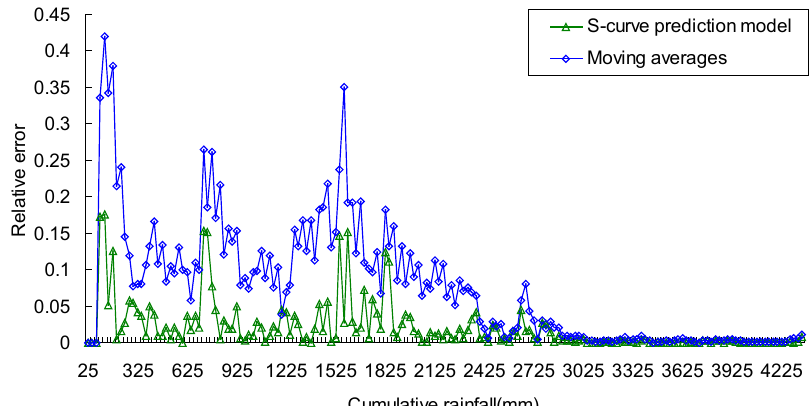
Figure 16. Relative error analyses of S-curve prediction model and moving averages model (Sample 1-25